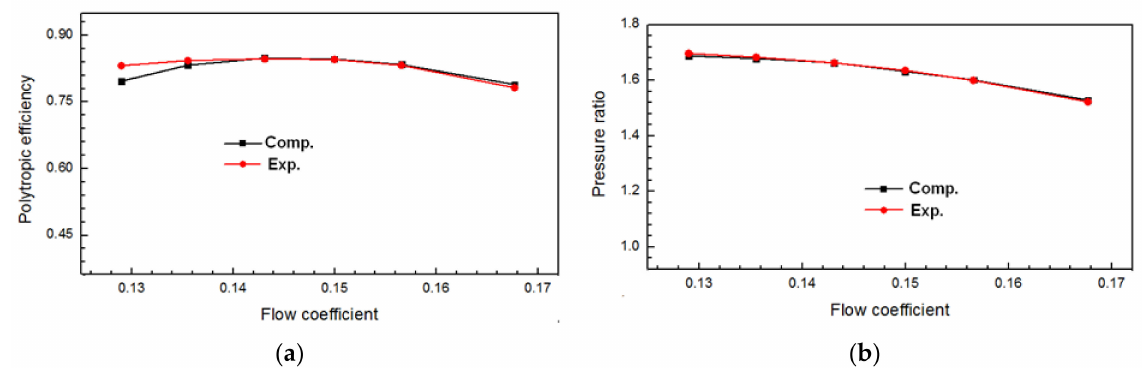
Figure 5. Comparison of numerical simulation with experimental data for the compressor perfor- mance. ( a ) Polytropic efficiency and ( b ) Total pressure ratio.